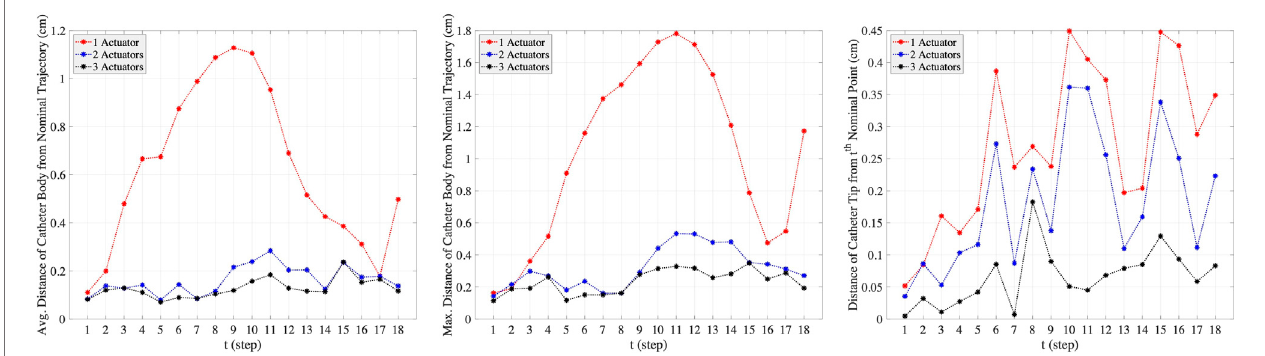
FIGURE8| Theaverage and maximum distance ofcatheterbody from thenominal trajectoryand thedistanceofcatheter tip from thenominalpoints, achieved by one-actuator,two-actuator,andthree-actuatorcathetersintrackingthetrajectoryscenario1.Themaximumthresholddistancesintheconstraintsare d body